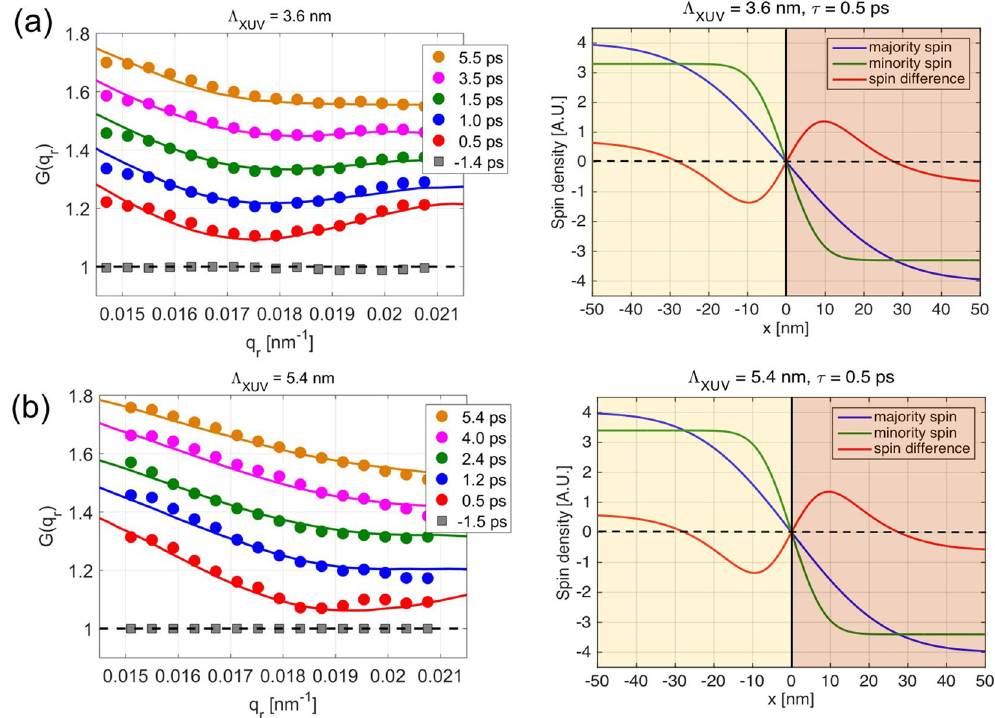
Figure 2. Measured and calculated distortion functions and spin difference profiles. The left panels display the distortion functions from the measured azimuthally structure factors (filled symbols) and the corresponding calculated distortion functions (solid lines) following the model described in the SI for the XUV penetration depths. The distortion functions for different delays for each penetration depth are vertically shifted for clarity. The right panels show the majority spin profile ( ↑ m x ( ) ), minority spin profile ( ↓ m x ( ) ) and the spin difference profile ( − ↑ ↓ m x m x ( ) ( ) ) for a pump-probe delay of τ = 0.5 ps. The spin up domain (Co ↑ ) exists for < x 0 and the spin down domain (Co ↓ ) for > x 0 with the domain boundary at x =